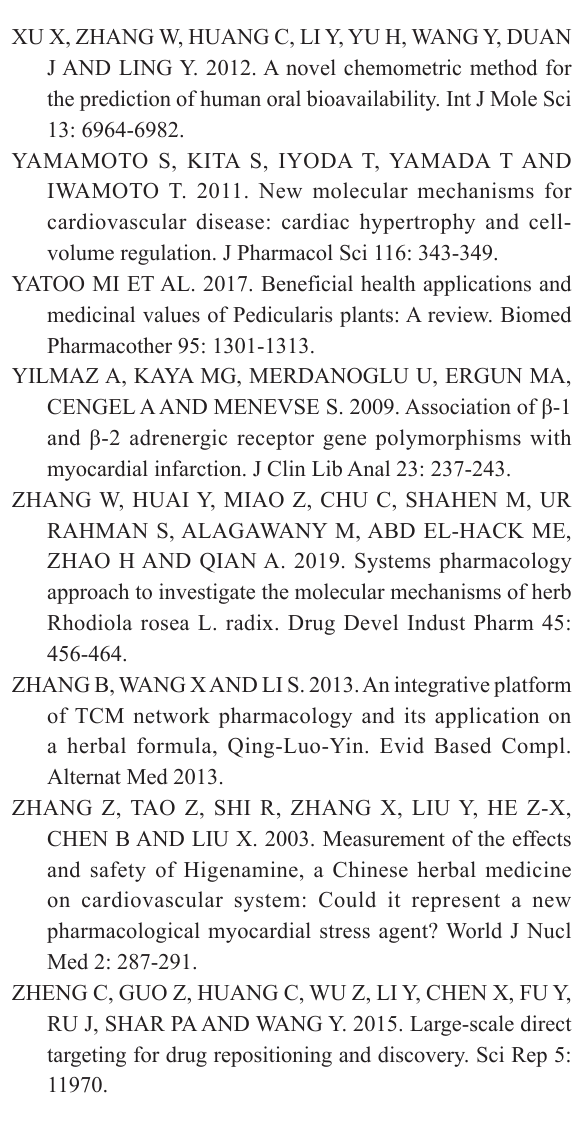
Table SI - Components of drugs in SND. Table SII - targets of